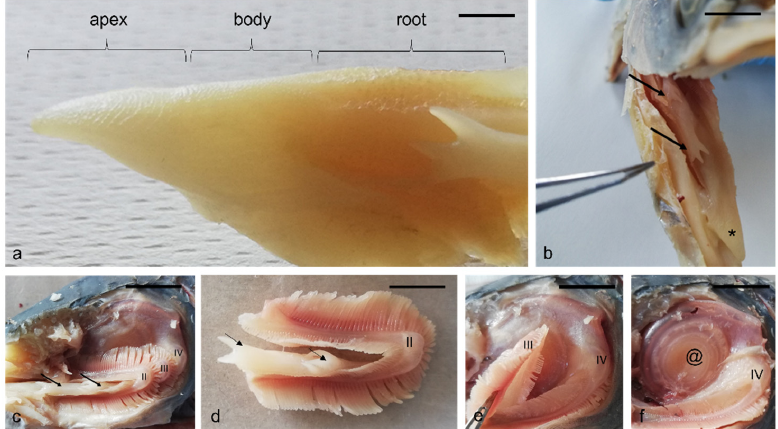
Figure 1. Gross anatomy. ( a ) The macroscopical aspect of H. niloticus tongue with three different areas: an apex, a body, and a root. ( b ) The opened oropharyngeal cavity showing the apex (asterisk), tubular organs on the sides of the tongue with digitiform ends (arrows). ( c , d ) Tubular organs (arrows) associated with the second gill arch (II). The third gill arch (III) ( e , f ) The fourth branchial (IV) arch modified in a spiral-shaped filtering apparatus (@). Scale bar: 1 cm.